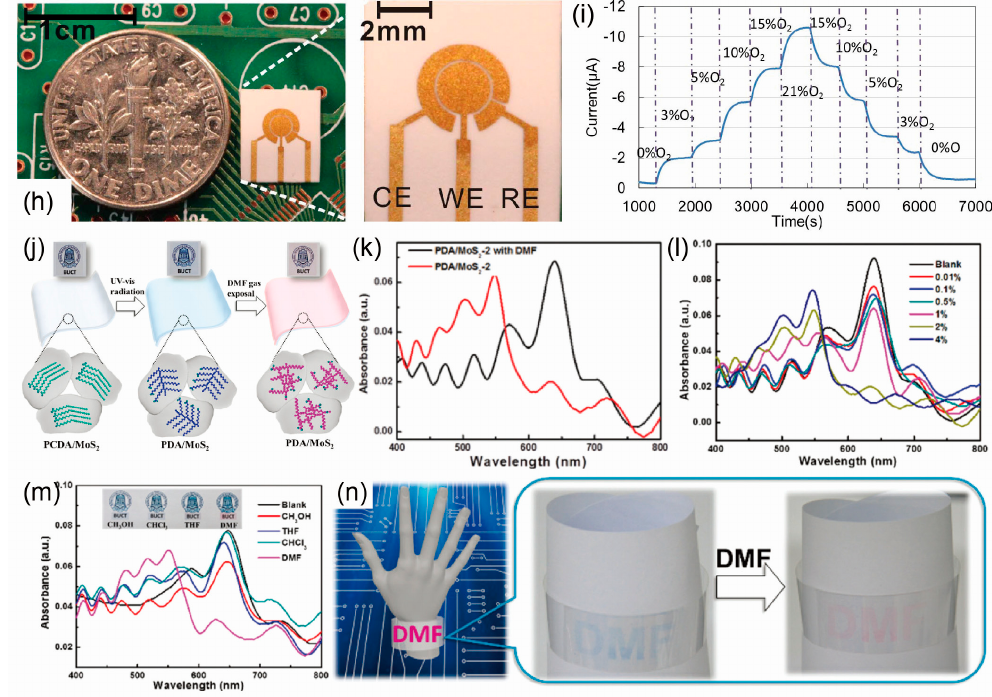
Figure 4. Wearable gas sensors and its integrated systems. ( a ) Photograph of transparent and flexible single-layer graphene (SLG) sensor channel-bilayer graphene (BLG) heater on a polyethersulfone (PES) substrate (scale bar 7 mm). ( b )Temperature distribution along transverse (x-axis) and longitudinal (y-axis) direction of sensor-heater device structured as laterally intercalated SLG sensor channel (6 mm width) between BLG heaters (7 mm width) with applied 1.7 W of electric power. Here the red dot and blue dot are temperature profiles of thermal image in inset along x-axis and y-axis with origin at center on channel, respectively. Inset: Spatial temperature distribution of graphene heaters (7 mm width) which intercalate 6 mm width graphene sensor with applied 1.7 W. Here three broken squares indicate center channel and side heaters area, respectively (scale bar 7 mm). ( c ) Recovering time constant τ r as a function of heater temperature. Inset: the recovering curves of the ∆ R / R 0 as a function of time under different temperature range from room temperature to 250 ◦ C. ( d ) The relative resistance variation ∆ R / R 0 of SLG channels as a function of time including recovery step with 100 to 165 ◦ C heating under different NO 2 gas concentration from 40 to 0.5 ppm. Reprinted with permission from Ref. [37] Copyright 2014, John Wiley and Sons. ( e ) Response curves of the sensor to NO 2 of different concentrations. Inset: The sensor response depends linearly on NO 2 concentration. ( f ) Response curves of the sensor to 50 ppm of NO 2 when tested under different bending angles. ( g ) Response curves of the sensor tested before and after bending 1000 and 5000 times (bending angle = 50 ◦ ). Reprinted with permission from Ref. [114] Copyright 2014, John Wiley and Sons. ( h ) Photograph of microfabricated flexible room temperature ionic liquid (RTIL) based gas sensor (scale bars 1 cm and 2 mm, respectively). ( i ) Current versus time curve at various oxygen concentrations when the potential is held at − 1.4 V vs. Au. Nitrogen is the background gas. Oxygen concentration steps up from 0% to 21% and steps down from 21% to 0%. Reprinted with permission from Ref. [117] Copyright 2013, IEEE. ( j ) Schematic illustration of the preparation of the PDA/MoS 2 film and the sensor upon exposure to DMF vapor. ( k ) UV-vis spectra of polydiacetylene (PDA)/MoS 2 composites with an increased ratio of MoS 2 to PDA in the absence and presence of 0.1% DMF vapor. ( l ) UV-vis spectra of PDA/MoS 2 films exposed to N , N -dimethylformamide (DMF) vapor with different concentrations. ( m ) UV-vis spectra of the PDA/MoS 2 film upon exposure to different (5%) vapors, in comparison with 2% DMF vapor. ( n ) Flexible transparent wrist strap with DMF sensing ability. Reprinted with permission from Ref. [110] Copyright 2017, Royal Society of Chemistry.